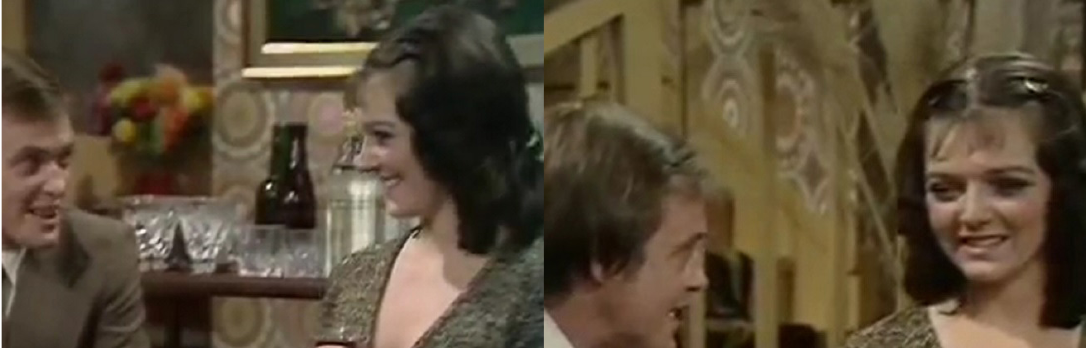
Figure 1: Terry speaking to Brenda (15:09) Figure Two: Brenda’s reaction